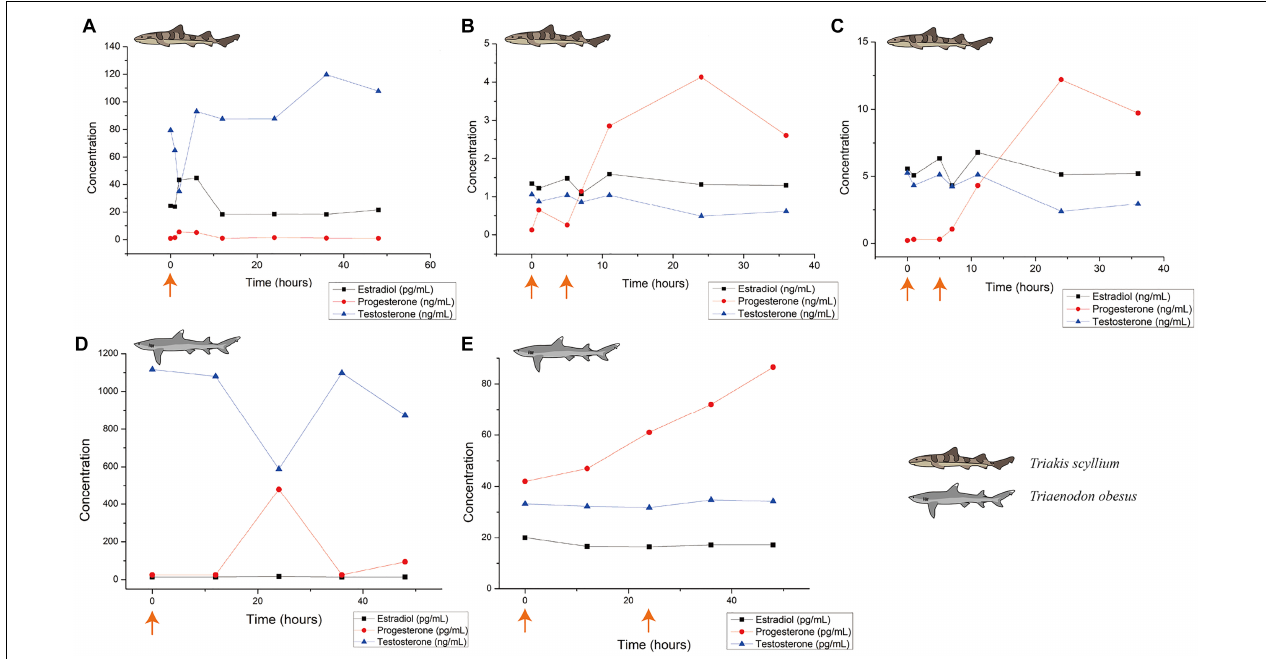
FIGURE 3 | Blood hormone level changes after Ovaprim R (cid:13) injection in Triakis scyllium and Triaenodon obesus . (A) Average hormone concentration changes in male T. scyllium . Ovaprim R (cid:13) was injected at 0.2 mL/kg dose at the orange arrowed time point. (B) Average hormone concentration changes of female T. scyllium . Ovaprim R (cid:13) was injected at 0.6 mL/kg dose at the orange arrowed time points. (C) Average hormone concentration changes of T. scyllium (Female #3; F003). Ovaprim R (cid:13) was injected at 0.6 mL/kg dose at the orange arrowed time point. (D) Average hormone concentration changes of male T. obesus . Ovaprim R (cid:13) was injected at 0.2 mL/kg dose at the orange arrowed time point. (E) Average hormone concentration changes in female T. obesus . Ovaprim R (cid:13) was injected at 0.2 mL/kg and 0.3 mL/kg doses in serial at the orange arrowed time